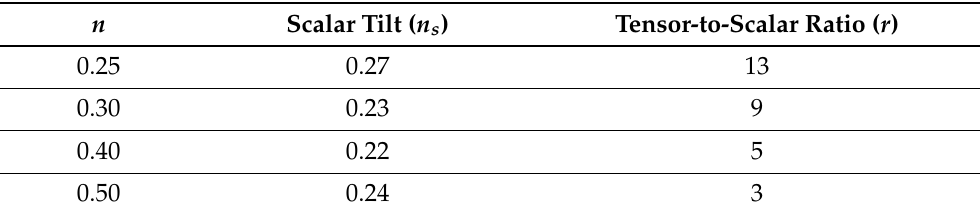
Table 3. Values of n s and r with the parameter n for t s >